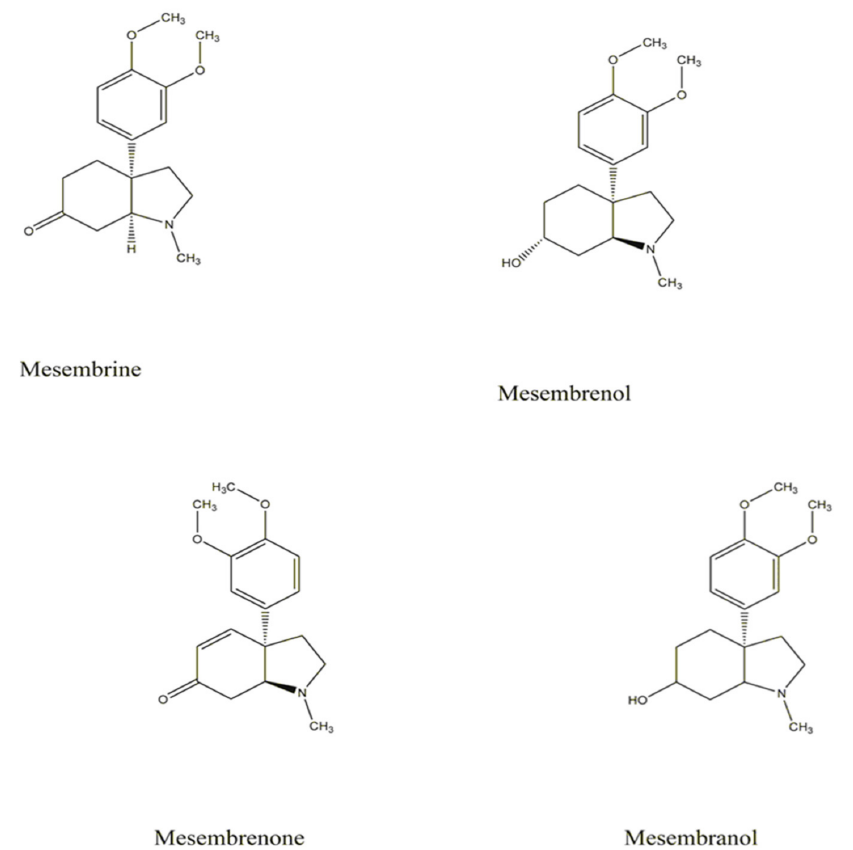
Figure 3. Chemical structures of the mesembrine alkaloids of Sceletium tortuosum [24,29]. 5. Biological and Pharmaceutical Properties of Sceletium